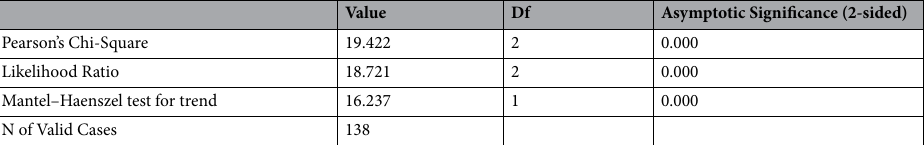
Value Df Asymptotic Significance (2-sided) Pearson’s